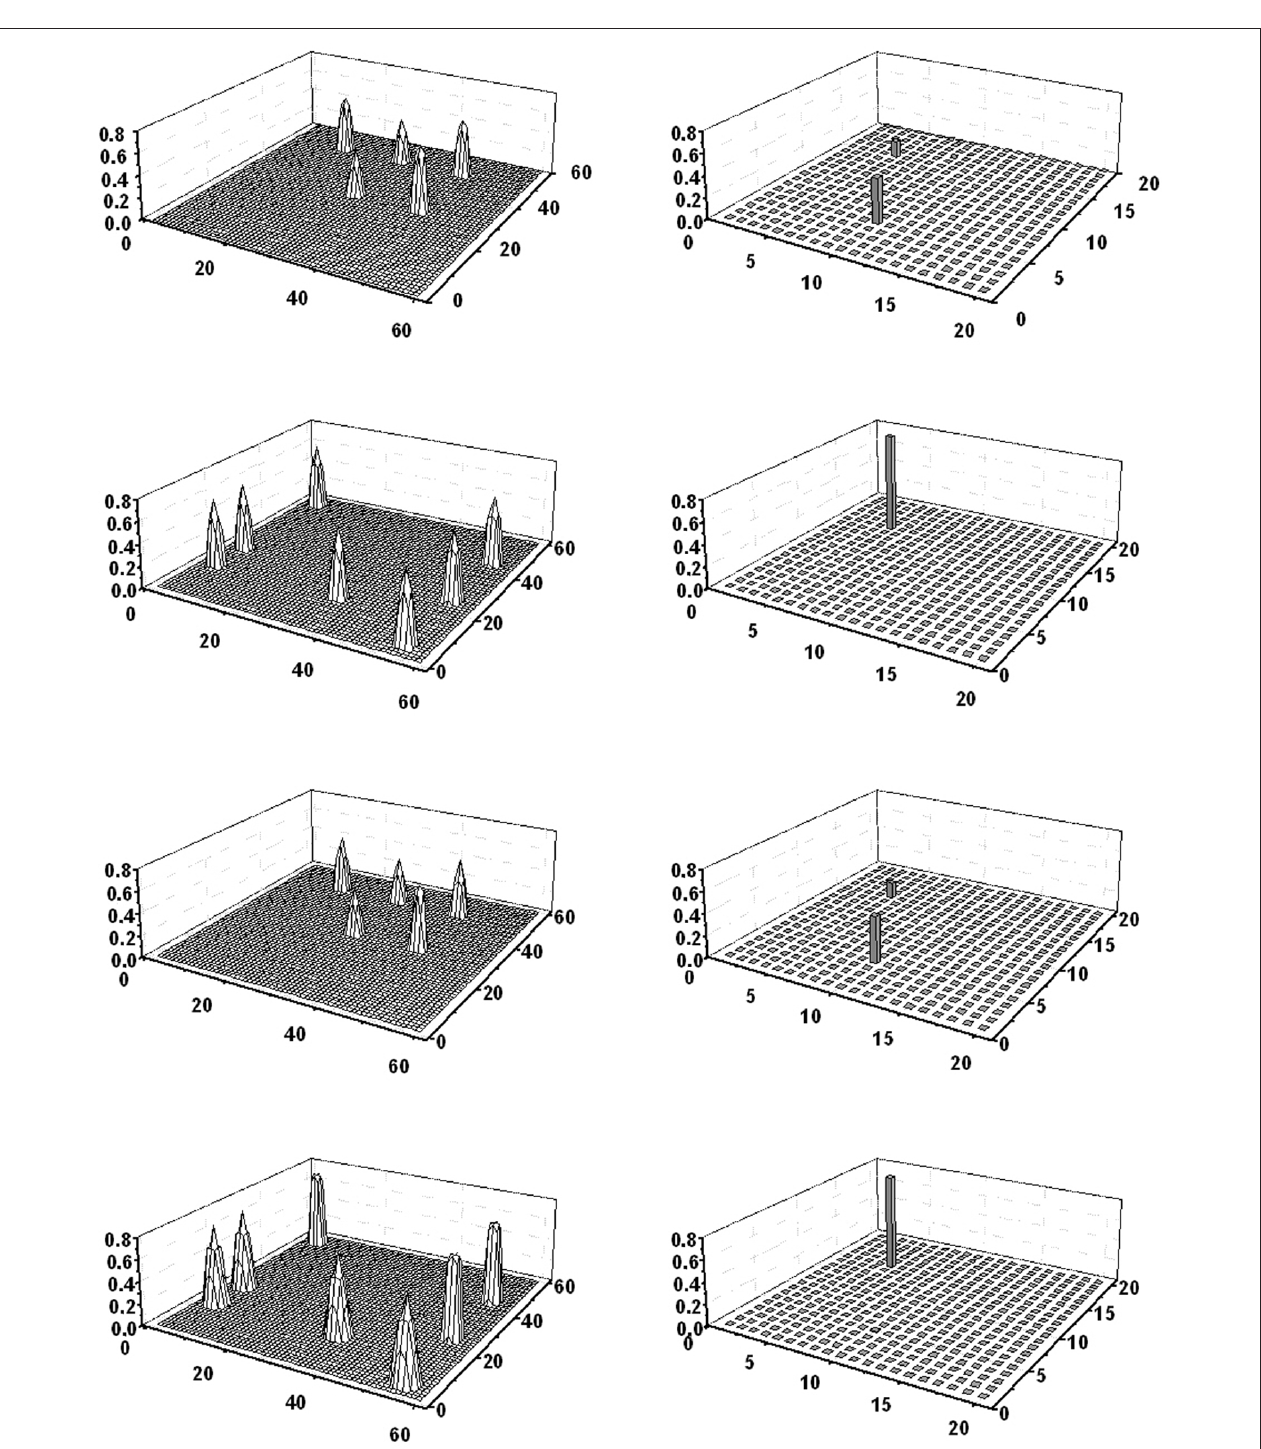
is completely reconstructed in the semantic network, the word coding for obj1 is activated in the lexical network, while the word coding for obj3 is inhibited. At step 156 (second line), when the conceptual representation of obj1 has been switched off, the word coding for obj3 evokes its conceptual representation in the semantic network. Then, the two representations alternate, oscillating in the gamma